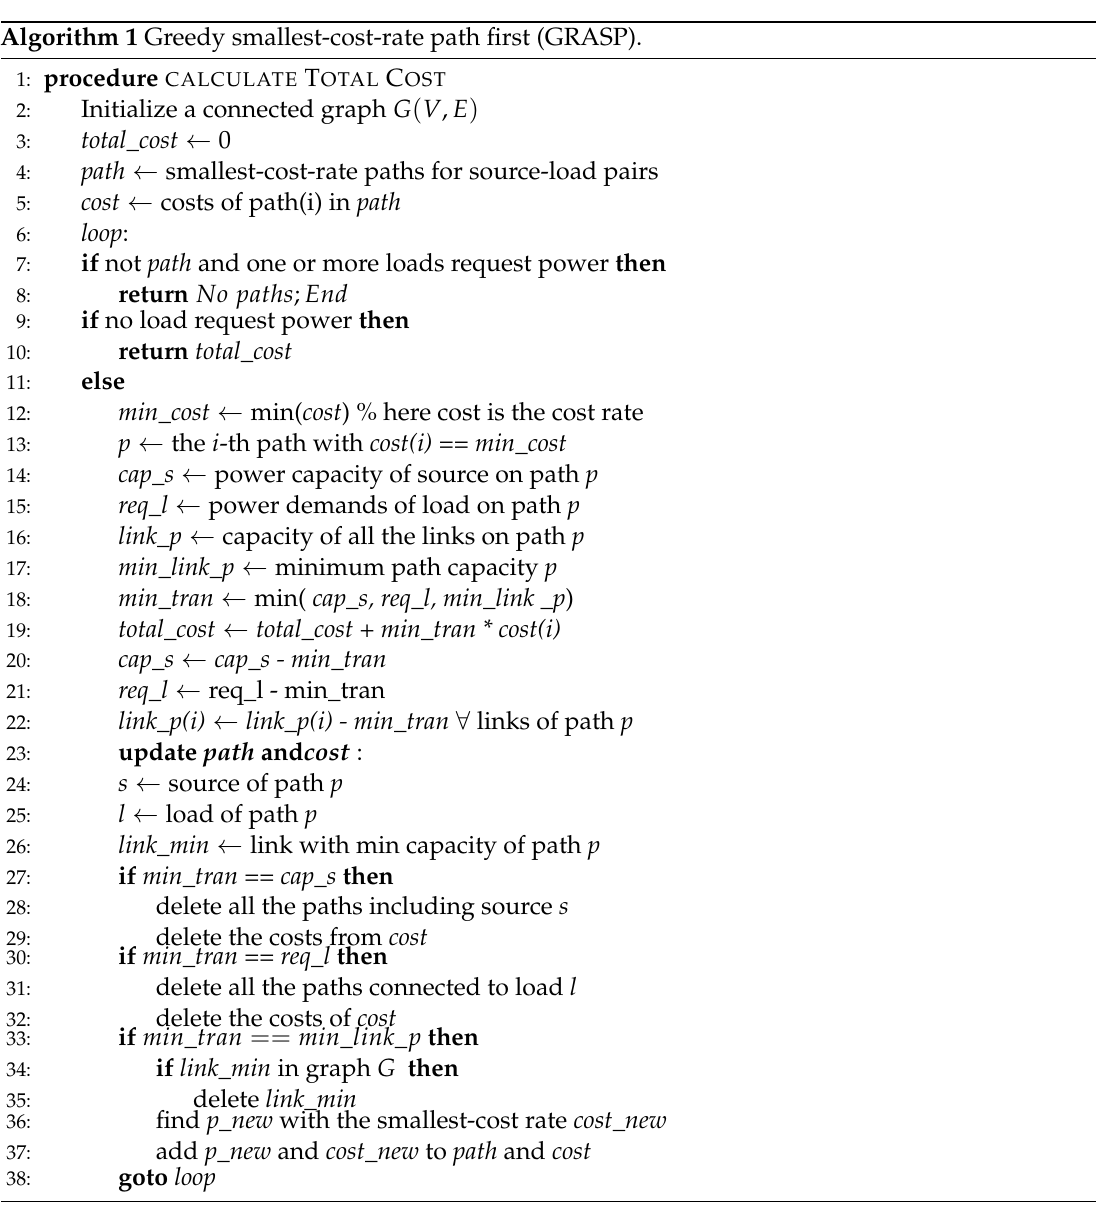
Algorithm 1 Greedy smallest-cost-rate path first